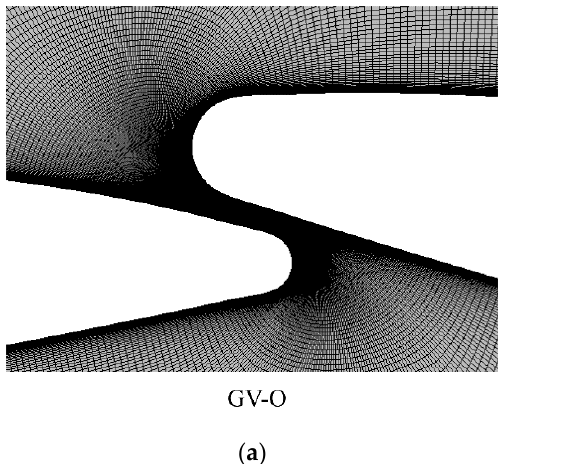
Figure 8. Schematic map of the mesh used in 3D CFD simulation.